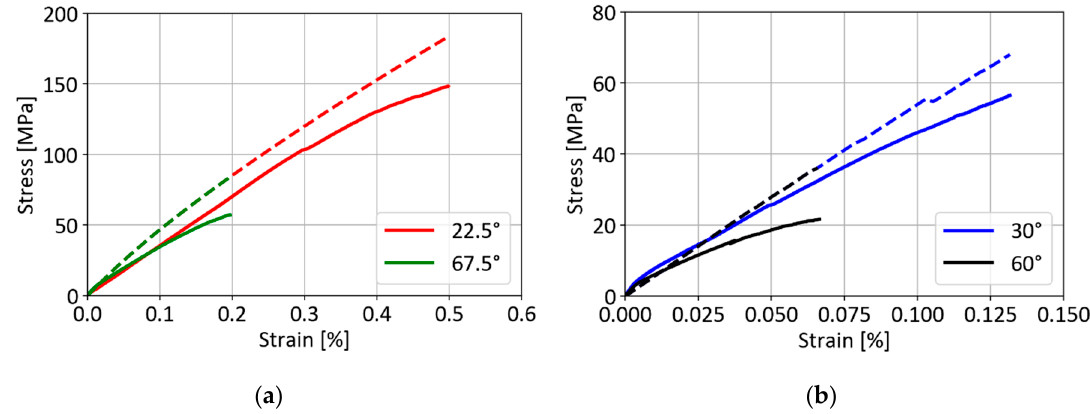
Figure 9. Comparison between the stress–strain curves obtained from simulation (broken line) and Iosipescu shear tests (solid line) with different fiber orientations for WHIPOX™. ( a ) ±22.5° and 67.5°; ( b ) ±30° and ±60°.